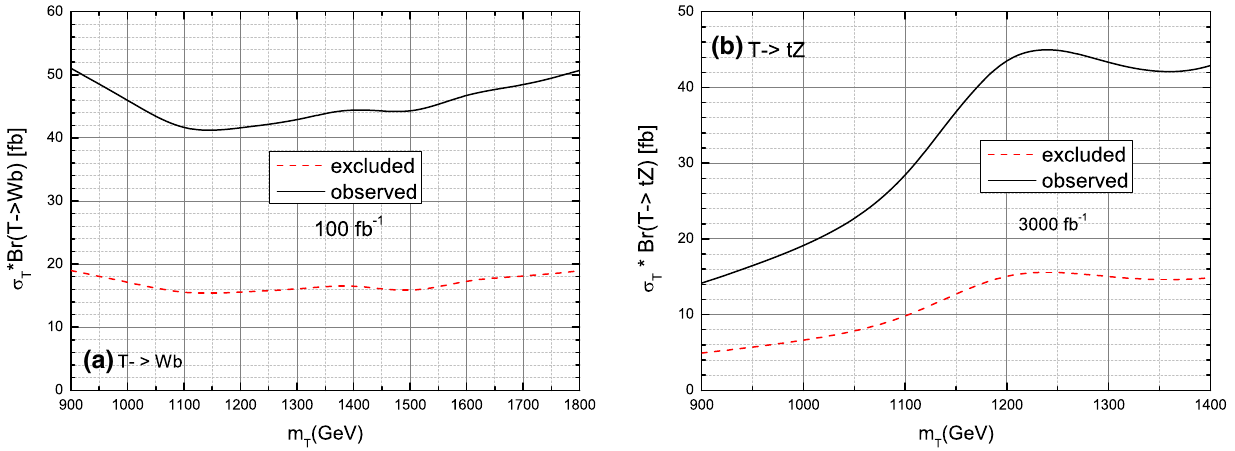
Fig. 10 The excluded and observed cross section for the signal as a function of the vector-like top partner m T at 14 TeV LHC for a T → Wb and b T → tZ